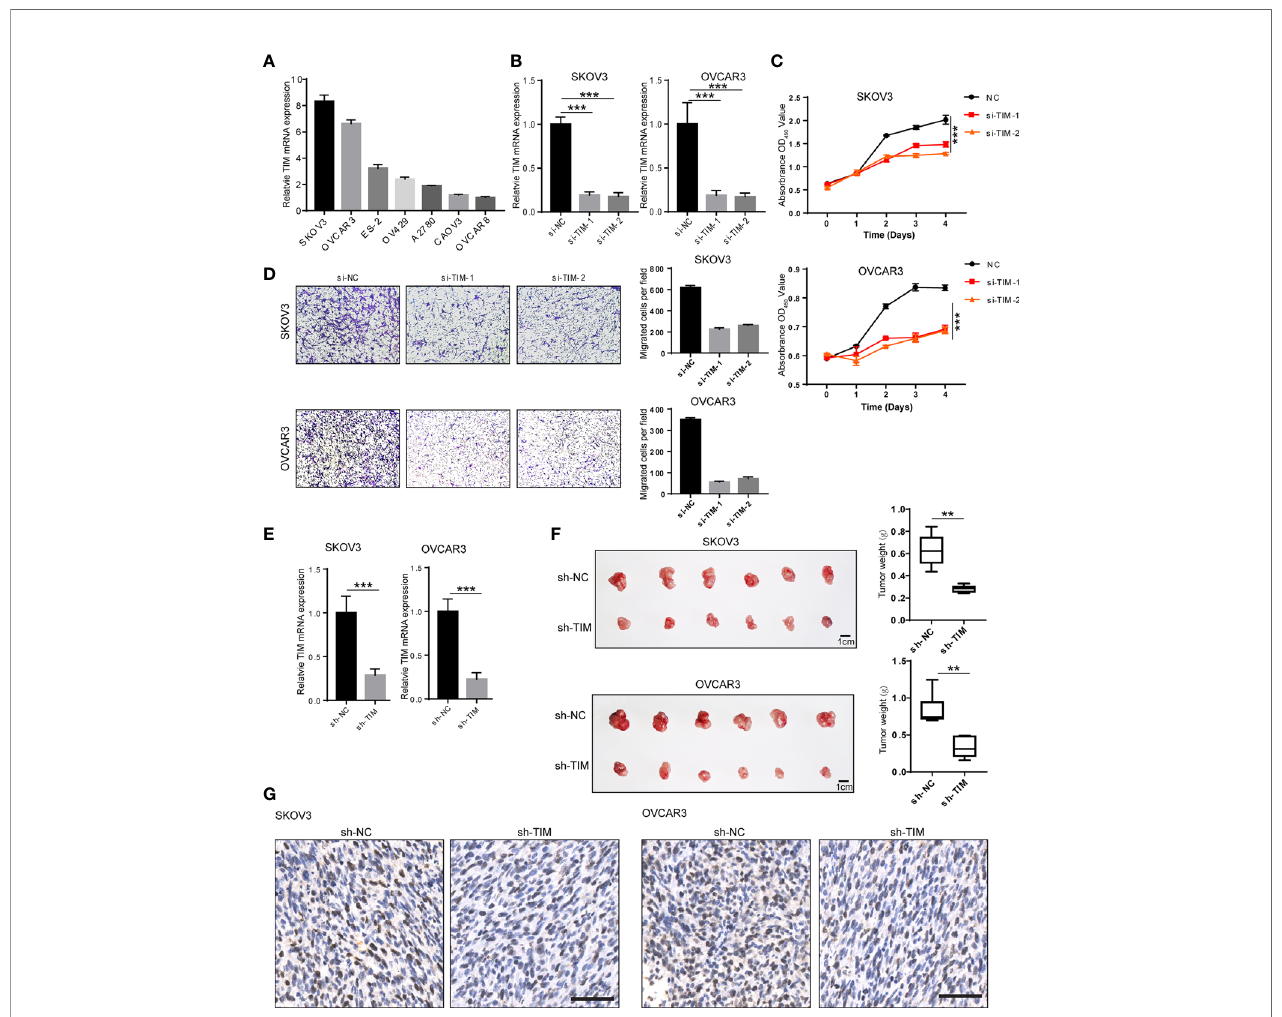
FIGURE 2 | TIM promotes OV cell proliferation and migration both in vitro and in vivo . (A) The expression of TIM mRNA was detected by qRT-PCR in different OV cell lines. (B) The Interfere ef fi cacy of TIM with either shRNA (si-TIM-1, si-TIM-2) or si-NC was analyzed by qRT-PCR. (C) The cell growth of SKOV3 and OVCAR3 in three groups (si-NC, si-TIM-1, si-TIM-2) was analyzed by CCK8 assay. (D) The migration of SKOV3 and OVCAR3 cells expressing si-TIM-1, si-TIM-2, or sh-NC was analyzed. (E) The interfere ef fi cacy of TIM with either sh-TIM or sh-NC was analyzed by qRT-PCR in SKOV3 and OVCAR3 cells. (F) Subcutaneous xenografts transplanted with either SKOV3 or OVCAR3 cells expressing sh-NC and sh-TIM in nude mice (n = 6). (G) Ki67 staining of the subcutaneous xenograft tumors from both sh-TIM and sh-NC group. Scale bar =100 m m. **p < 0.01, ***p <